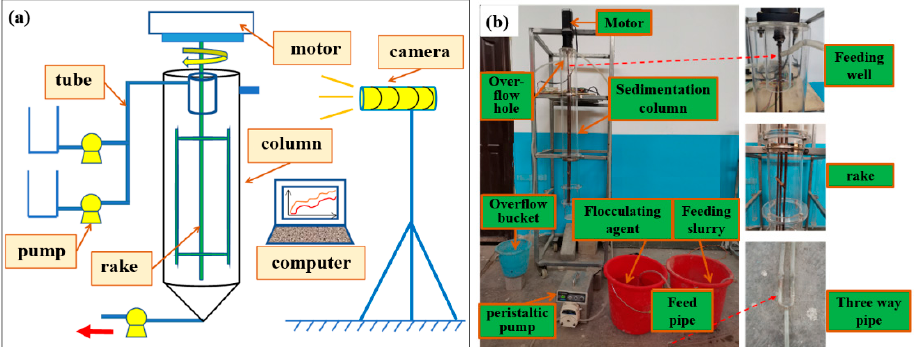
Figure 3. Thickener experiment platform ( a ) effect drawing of experimental device ( b ) layout of laboratory equipment.